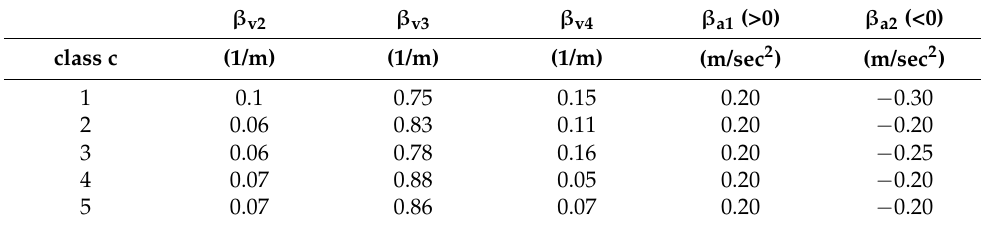
Table 2. Calibrated parameters of vector β for each link class